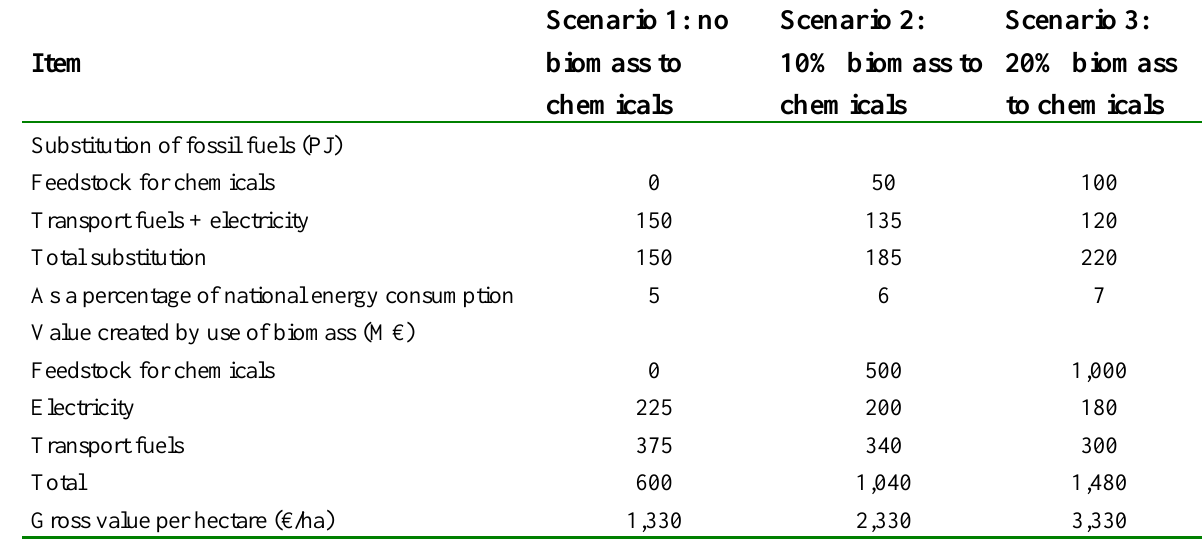
Table 2. Substitution of fossil fuels, and value created by biomass in three scenarios based on 25% of Dutch agricultural acreage devoted to production of